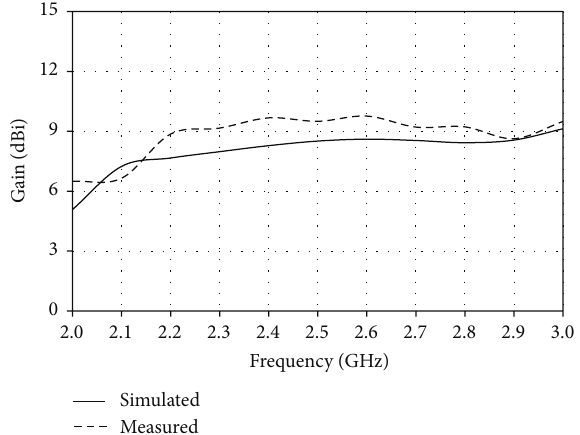
Figure 24: The simulated and measured antenna gains in front of the antenna (0 ∘